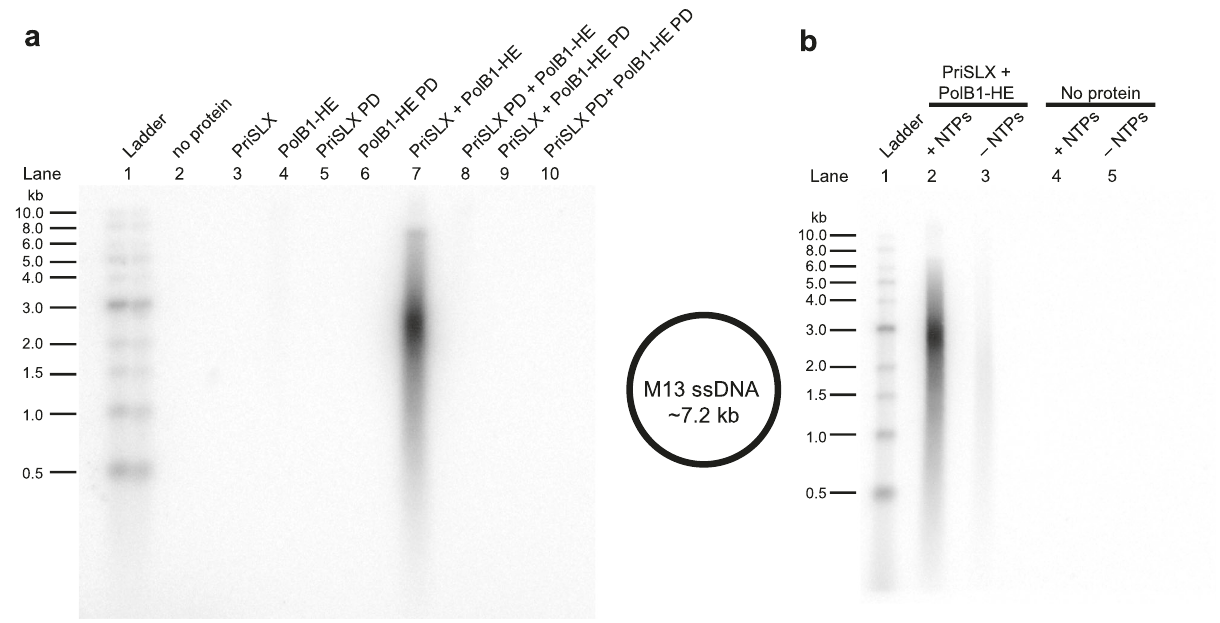
Fig. 1 In vitro replication by PriSLX and PolB1-HE. a Left panel: replication reactions containing 200 µ M NTPs; 30 µ M dNTPs; 2 µ Ci/10 µ L α - 32 P-dATP; 25 nM M13 ssDNA template; and 25 nM of protein(s) as indicated. 30 min at 75 °C. Right panel: representation of M13 ssDNA template. The suf fi x “ PD ” , Polymerase Dead, indicates versions of the primase and polymerase that have amino acid substitutions in the active site aspartate residues, D101,103A and D655,657A, respectively, that render them inactive. Two independent replicates of this experiment were performed. b Replication reactions with or without 200 µ M NTPs as indicated; 30 µ M dNTPs; 2 µ Ci/10 µ L α - 32 P-dATP; 25 nM M13 ssDNA template; and 25 nM of protein(s) as indicated. 30 min at 75 °C. Three independent replicates of this experiment were